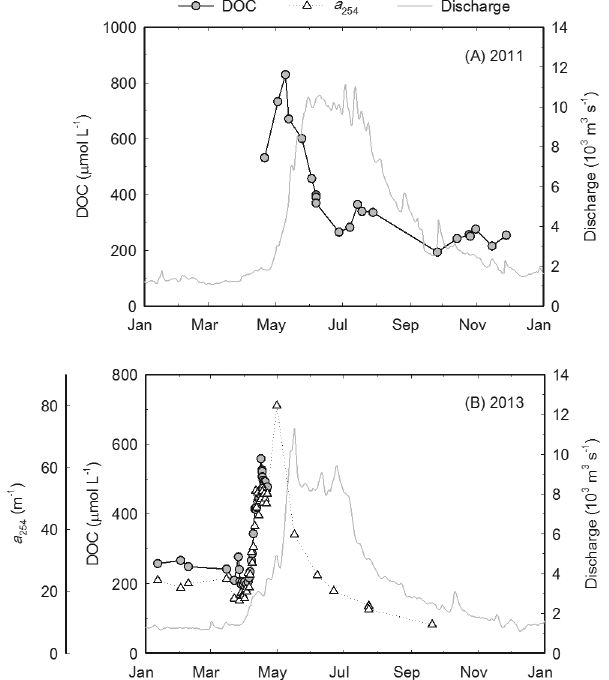
Figure 3. Concentrations of dissolved organic carbon (DOC) peak during the early stages of the spring freshet and decrease over the course of the summer.